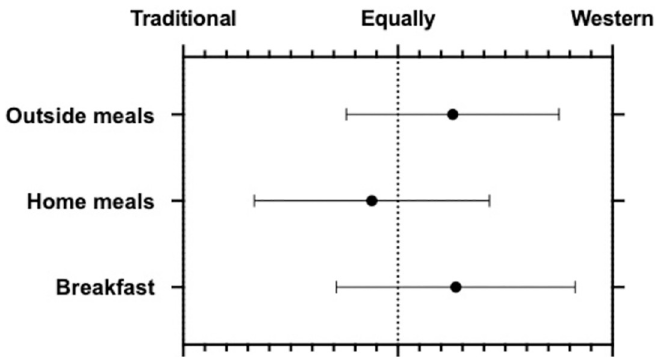
Fig 1. Meal pattern in Asian children with IBD. Meals trend toward a Westernized pattern, especially for outside meals and breakfast.